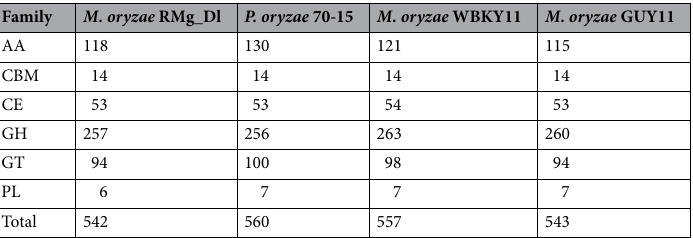
Table 3. The comparative CAZymes family profile in M. oryzae RMg_Dl, P. oryzae 70-15, M. oryzae WBKY11, and M. oryzae GUY11 genomes.